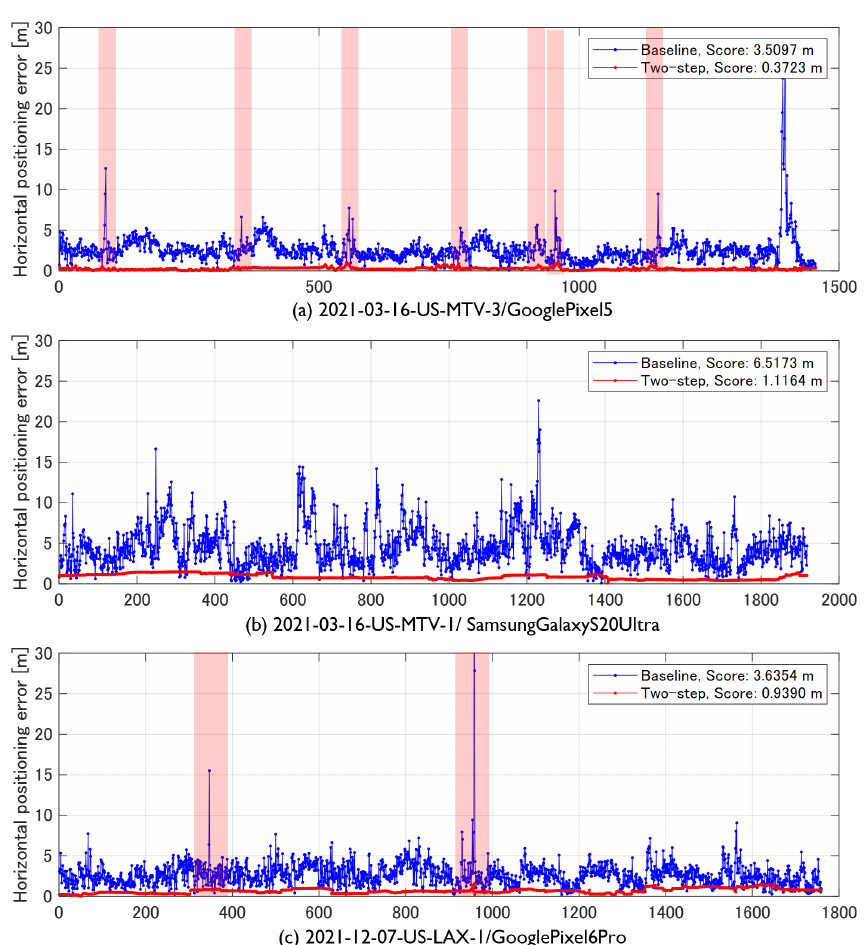
Figure 9. Comparison of horizontal positioning error between baseline (blue line) and proposed method (red